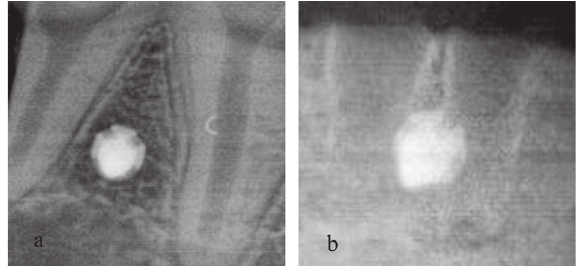
Figure 2- Radiographs illustrating implanted microscrews. (a) Radiograph of microscrew implanted between the roots of first molar. (b) Radiograph of a microscrew